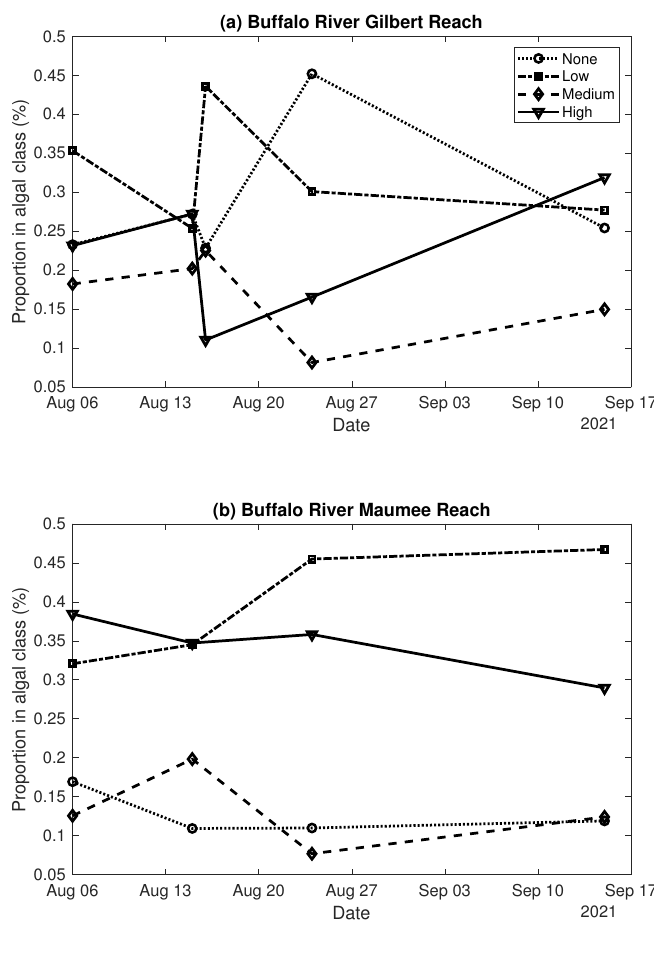
Figure 13. Variations over time in the proportion of image pixels assigned to each algal density class for the ( a ) Gilbert and ( b ) Maumee